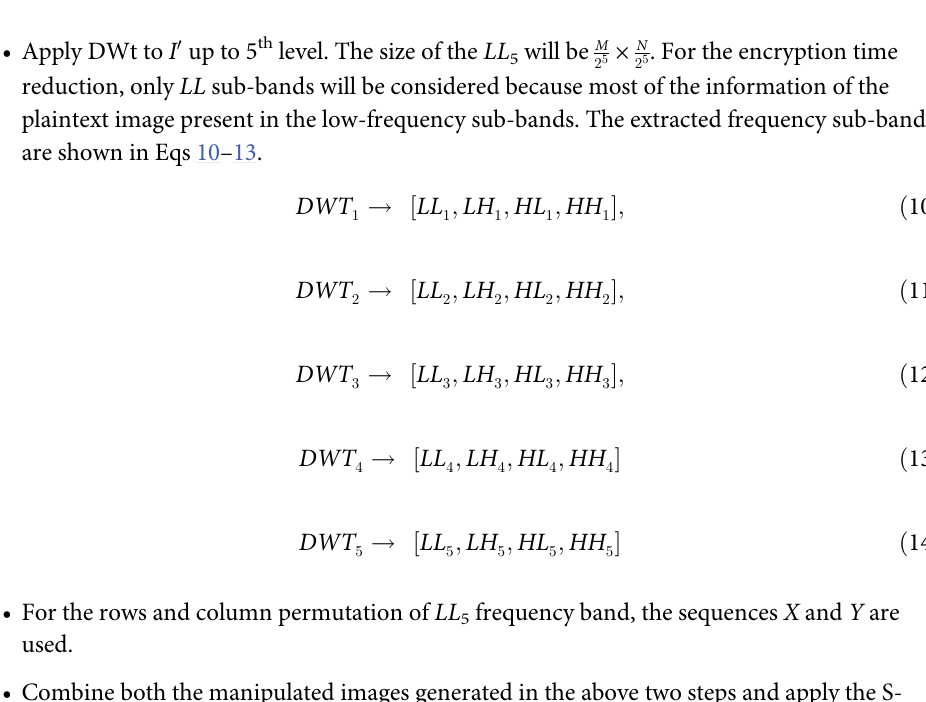
Algorithm 1 Substitution of LL